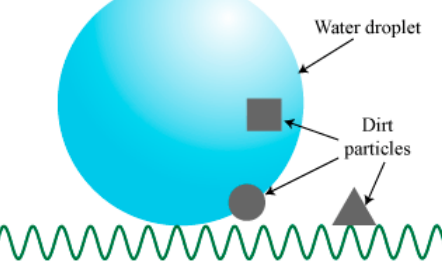
Figure 1. Self-cleaning effect on the surface of a leaf.